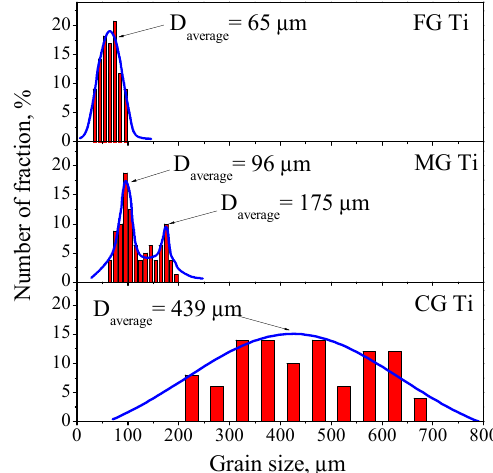
Figure 2. TEM images of the initial CG Ti sample: ( a ) light filed image, ( b ) select electron diffraction pattern, and ( c ) the corresponding dark filed image.